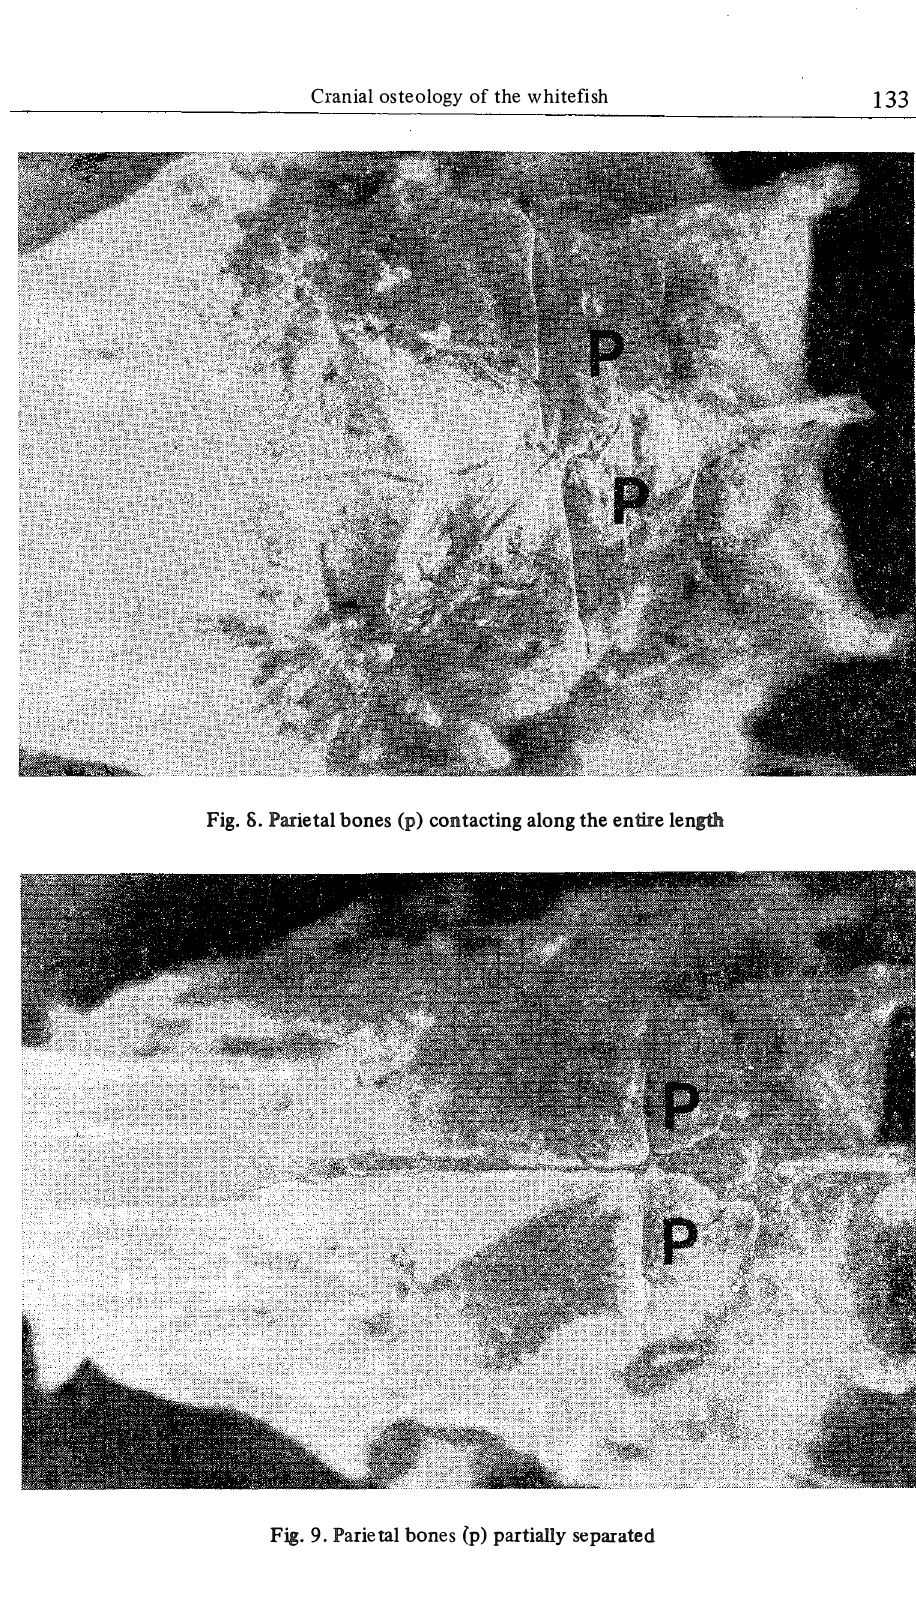
Fig. 9. Parietal bones {p) partially